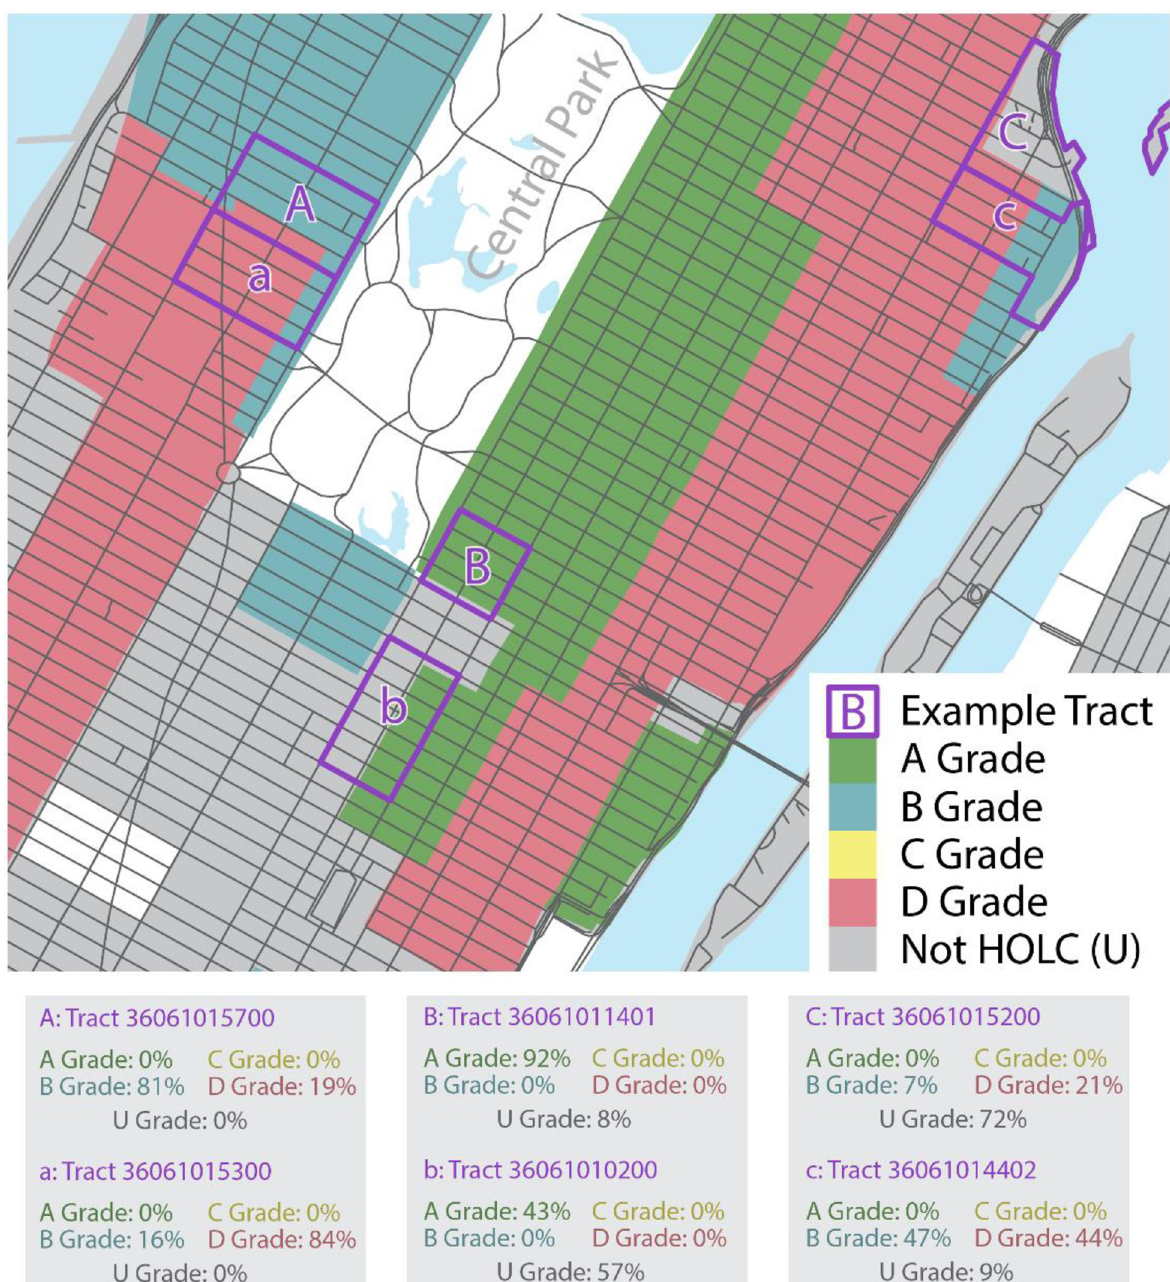
Fig 1. Census tracts and HOLC-rated polygons in Manhattan, New York City. Note: The map image was created using the 2019 TIGER/Line Shapefiles (machine readable data files) / prepared by the U.S. Census Bureau and HOLC rating data published by the Digital Scholarship Lab under a Creative Commons Attribution-NonCommercial-ShareAlike 4.0 International License (https://creativecommons.org/licenses/by-nc-sa/4.